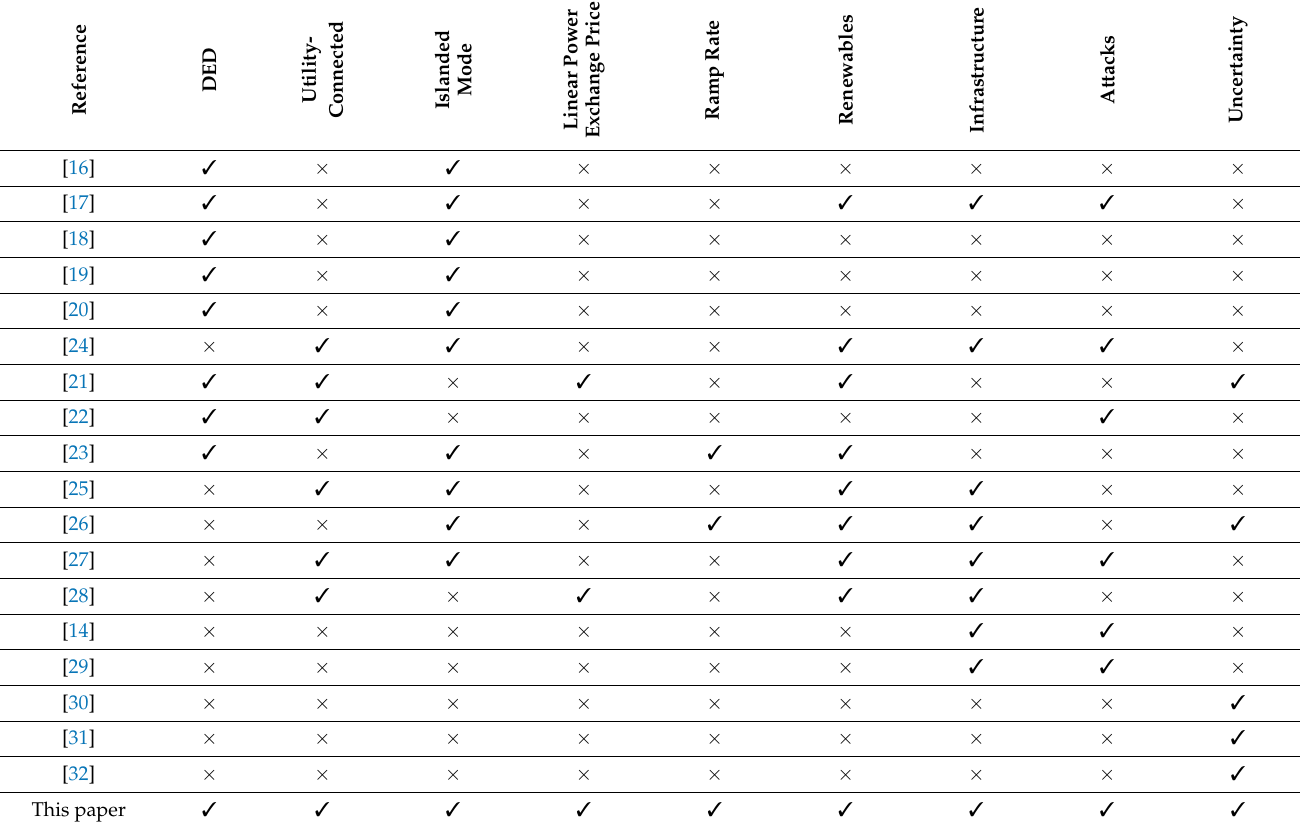
Table 1. A review of the related literature focusing on the key features investigated in the